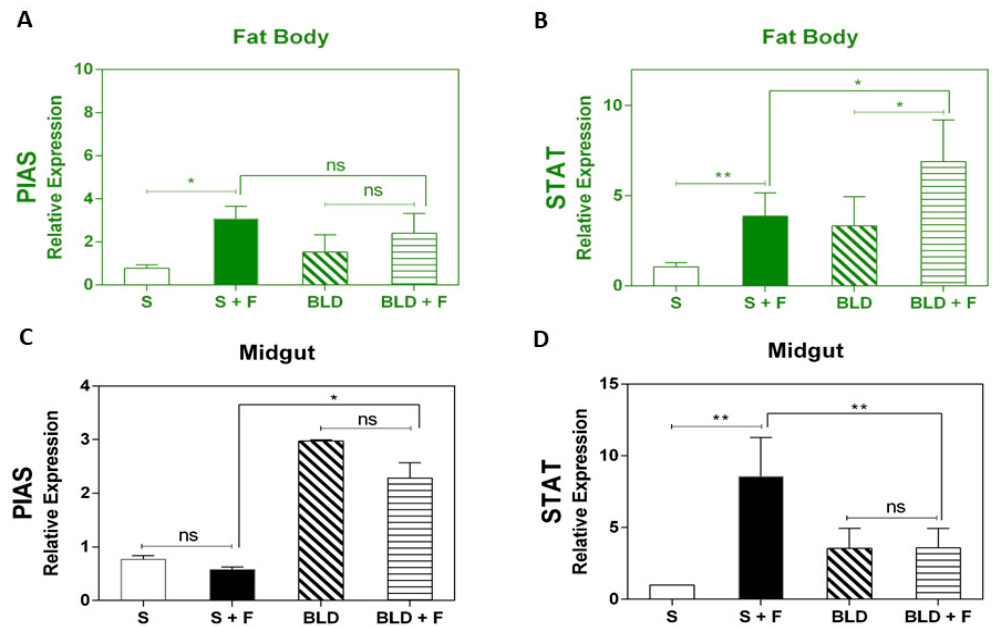
Figure 4. Expression analysis of the JAK-STAT pathway marker genes after exposure of A. aegypti to M. anisopliae . Gene expression analysis of PIAS, and signal transducer and activator of transcription STAT both in the midgut and fat body of sugar-fed and blood-fed mosquitoes at 48 h post infection. The insects were fed with either sucrose (10%) or mouse blood. Immediately after feeding, mosquitoes were sprayed with 0.05% Tween 80 with or without M. anisopliae. Forty-eight hours post-infection, total RNA was extracted from mosquitoes, cDNA obtained, and RT-qPCR analyses were subsequently performed. Each bar represents the results from a pool of 15 female mosquitoes. Results are the means of four independent experiments. The p -values from pair-wise comparisons (comparing Tween treated to sugar-fed / blood-fed) were calculated using Student’s t -test and levels of significance were indicated for each bar (* p < 0.05; ** p < 0.01; *** p < 0.001; **** p < 0.0001). Negative controls were treated with 0.05% aqueous Tween